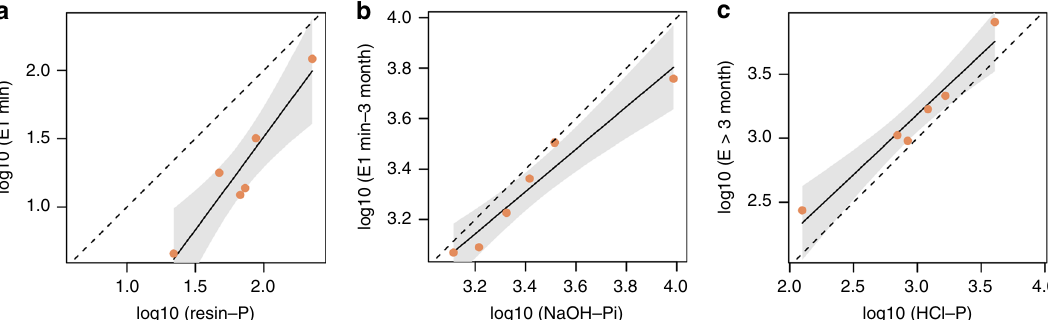
Fig. 3 Correlation between chemically extracted P pools and isotopically exchangeable P. Dashed lines represent the 1:1 line; shaded areas the 95% con fi dence regions of the regression curves. Resin-P correlated with P exchangeable within 1 min ( a ), NaOH-Pi with P exchangeable within 3 months, and HCl-P with P that is only exchangeable at time spans longer than 3 months ( b ). R 2 values were 0.9, 0.95, and 0.95, respectively, with all F -statistics >34 and p < 0.005